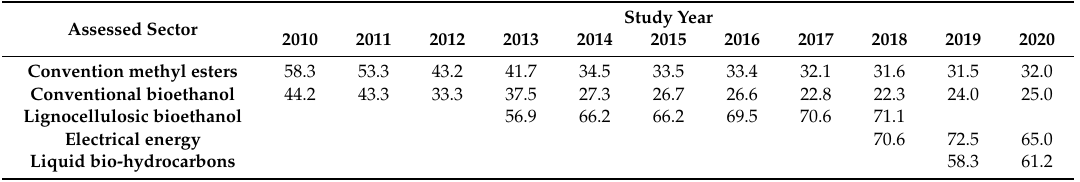
Table 5. Obtained study results regarding the values of selected Polish sectors of biocomponents and electric energy used in transport in 2010–2020